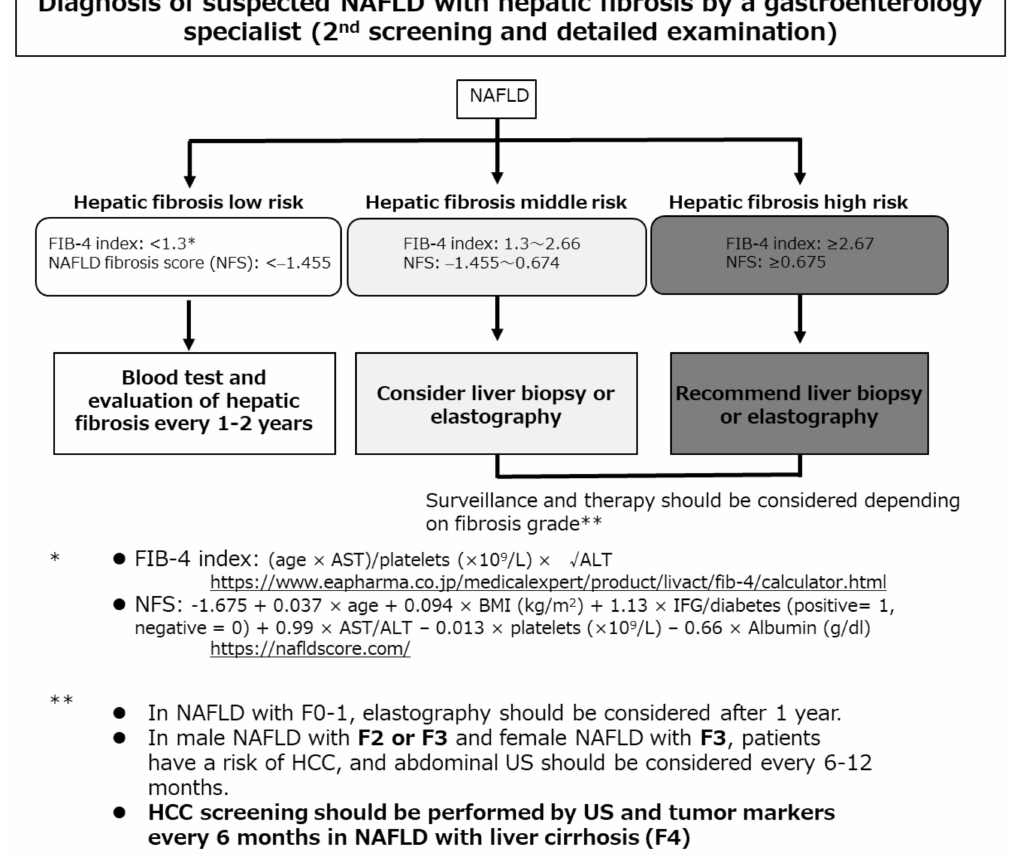
Figure 1. The algorithm for hepatocellular carcinoma screening and surveillance contained in the revised Japanese guidelines [6]. AST, aspartate aminotransferase; ALT, alanine aminotransferase; BMI, body mass index; FIB-4, Fibrosis-4; NFS, nonalcoholic fatty liver disease fibrosis score; IFG, impaired fasting glucose; NAFLD, nonalcoholic fatty liver disease; HCC, hepatocellular carcinoma; US,